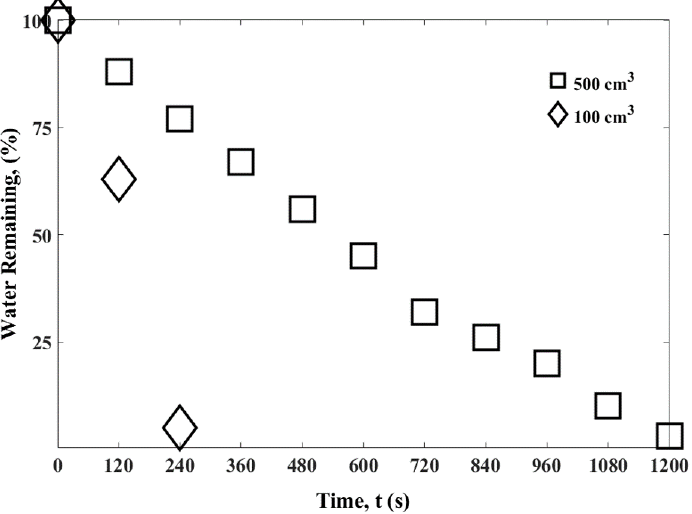
Figure 12. Water loss of foams as a function of drying time and sample size at 𝑃 𝑖𝑛 = 100% .